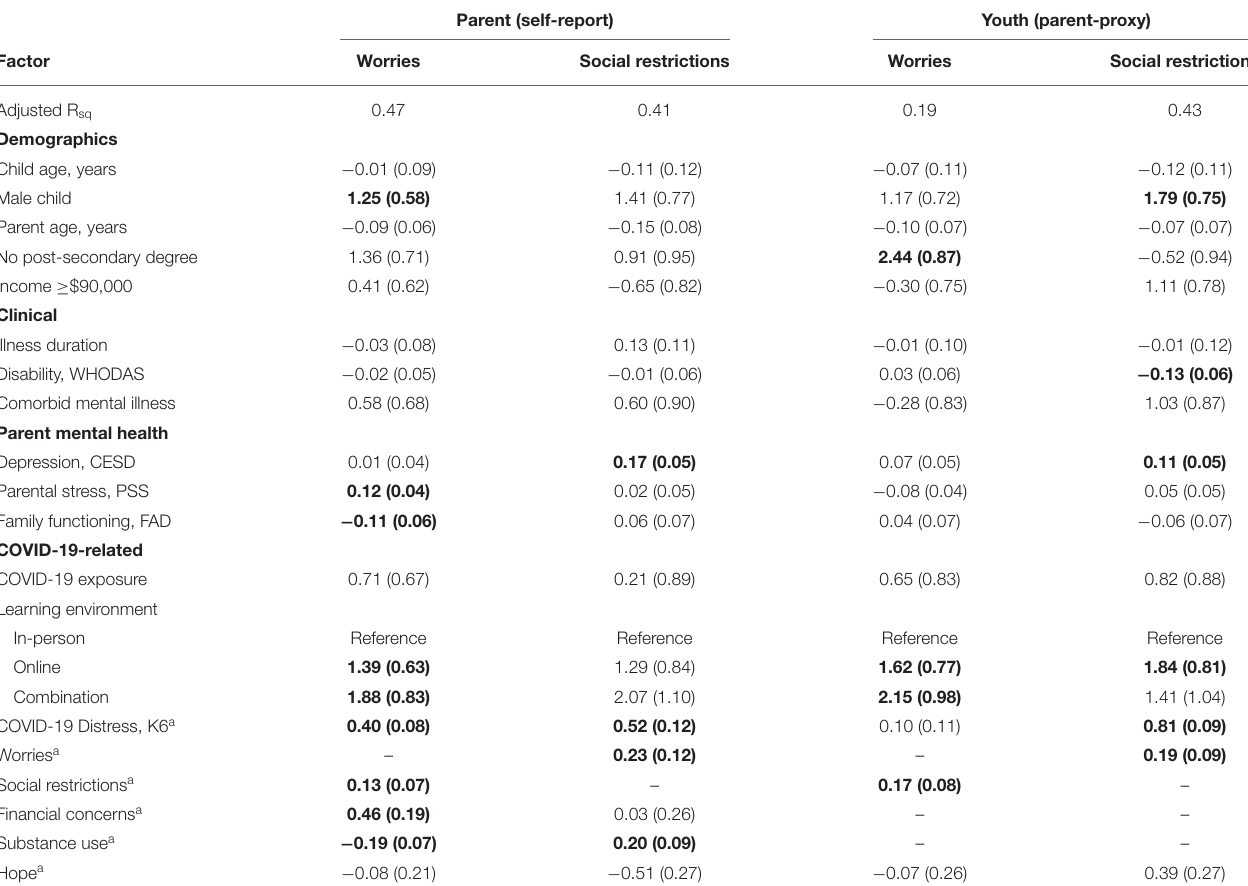
TABLE 5 | Factors associated with parent and youth COVID-19-related psychosocial outcomes